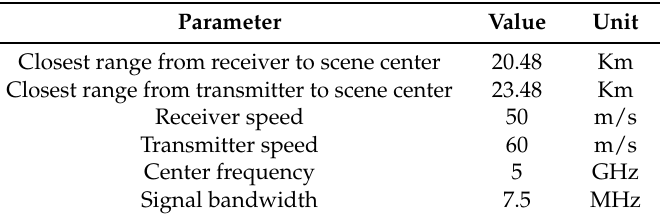
( b ) Figure 8. Point G: ( a ) amplitude plot and ( b ) contour plot. ( a ) ( b ) Figure 9. Point C: ( a ) amplitude plot and ( b ) contour plot.